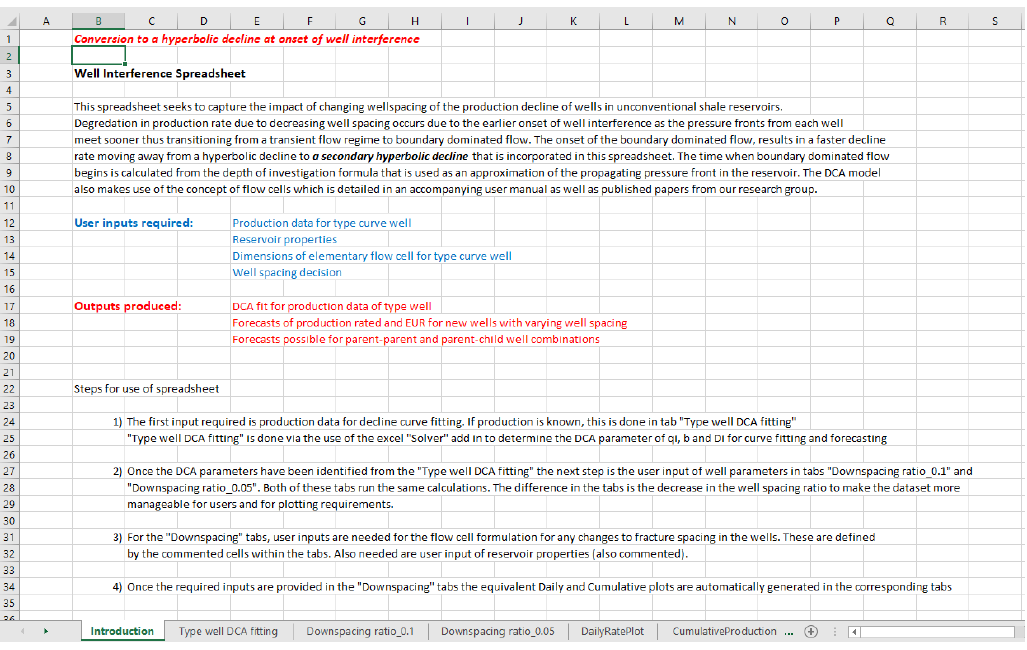
Figure A1. Screen capture of the “Introduction” tab.